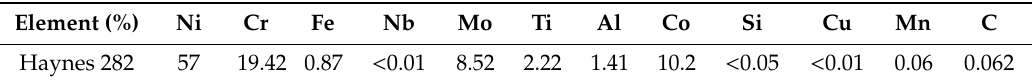
Table 1. Haynes 282 chemical composition